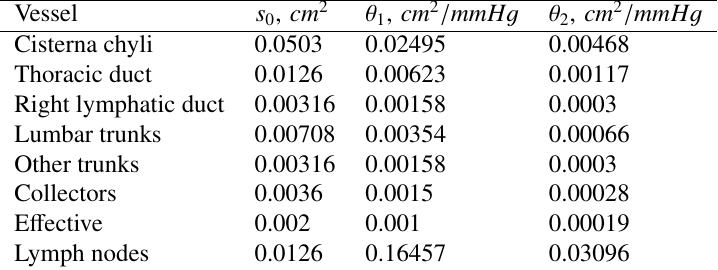
Table 3. Parameters of vessels of the graph